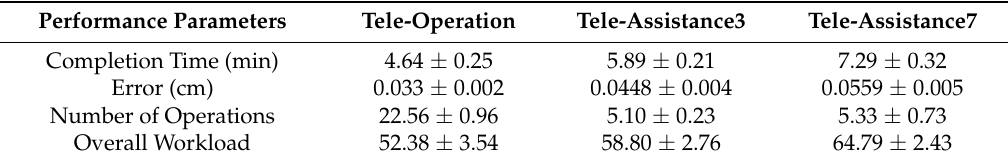
Table 1. Interactive strategies on the task